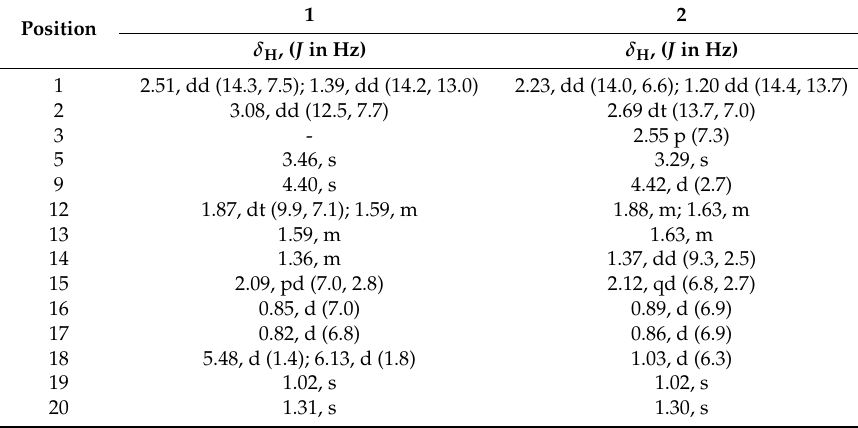
Figure 4. Plant disease control efficacies of the ethyl acetate extract of the Crinipellis rhizomaticola IUM00035 culture filtrate. n.s. indicates not shown, meaning that disease control effects of ethyl acetate Table 1. 1 H-NMR data (500 MHz) of 1 and 2 in CDCl 3